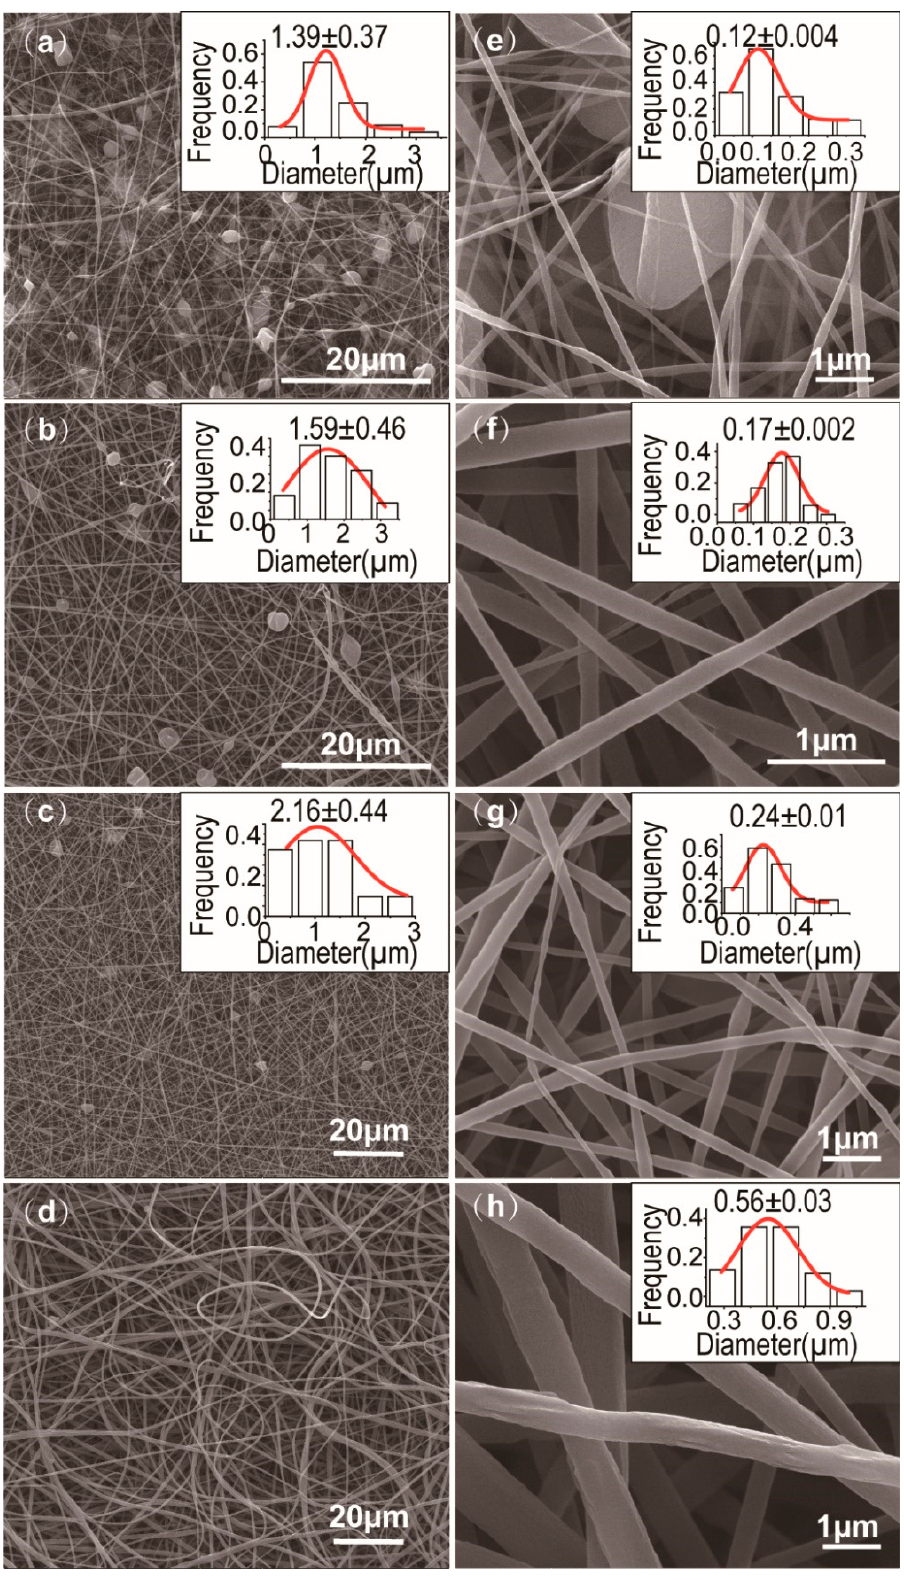
Figure 3. SEM images, average diameters and size distributions of the electrospun nanocomposites: ( a , e ) F1; ( b , f ) F2; ( c , g ) F3; ( d , h ) F4; ( a – c ) particle diameter distributions of the Janus nanostructures; ( e – h ) nanofiber diameter distributions of the Janus nanostructures.